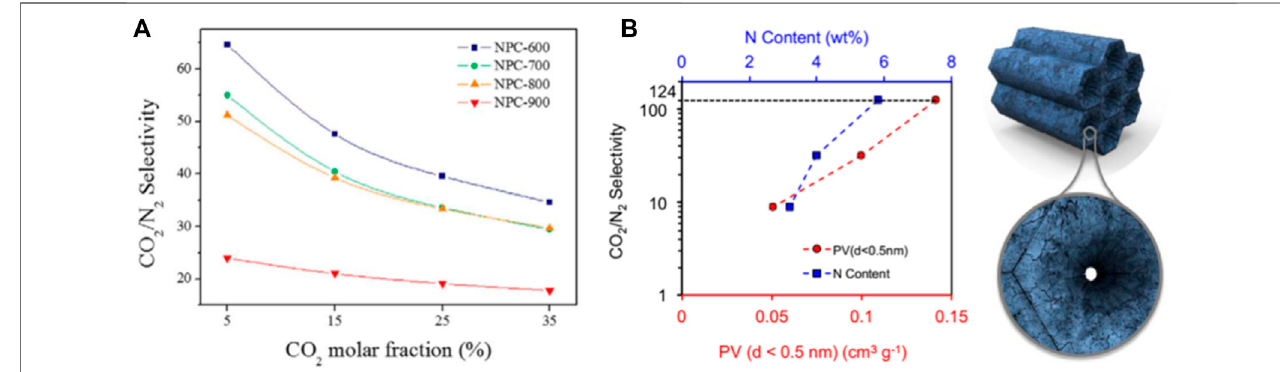
FIGURE 7 | Effect of nitrogen modi fi ed carbon-based adsorbent on CO 2 selectivity: (A) Nitrogen-containing pitch-based activated carbon (NPC) selectivity as a function of CO 2 mole fraction at 298 K and 1 bar total pressure (Lee et al., 2016); (B) The correlation between CO 2 /N 2 selectivity and ultra-small pore volume and the correlation between CO 2 /N 2 selectivity and N content (To et al.,